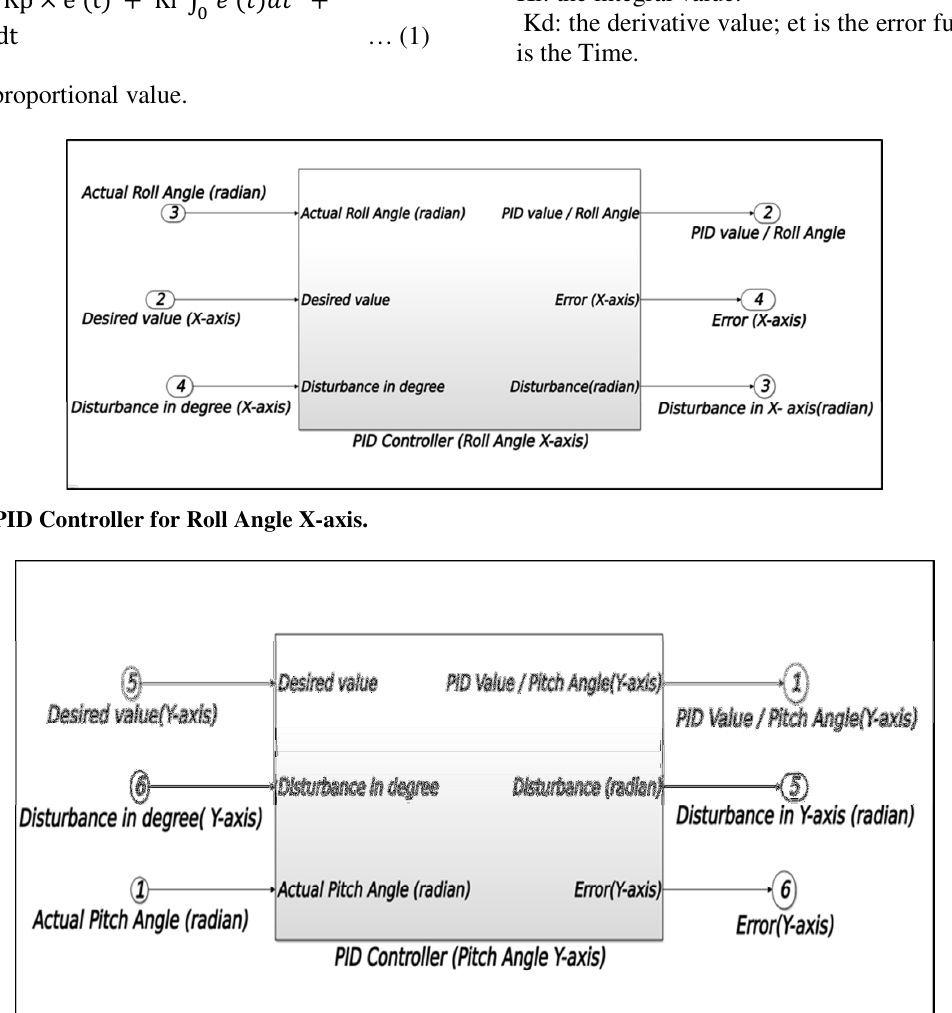
of the motors is for the Pitch Angle Y-axis (top plate), the other motor is for the Roll Angle X- axis (middle plate), as shown in the figure. 4. The kinematics modelling of DC servo motor for both Pitch Angle Y-axis Servo motor and the Roll Angle X-axis Servo motor (shown in figure.4) were simulated in Simulink as shown in Fig. figure.6. according to the equations (2) and (3) [22], the below block diagram of the DC servo motor is shown in figure.5 [23] and the motor parameters in the Table1. For this simulation, the parameters of an actual DC Servo motor were chosen from [19] and shown in